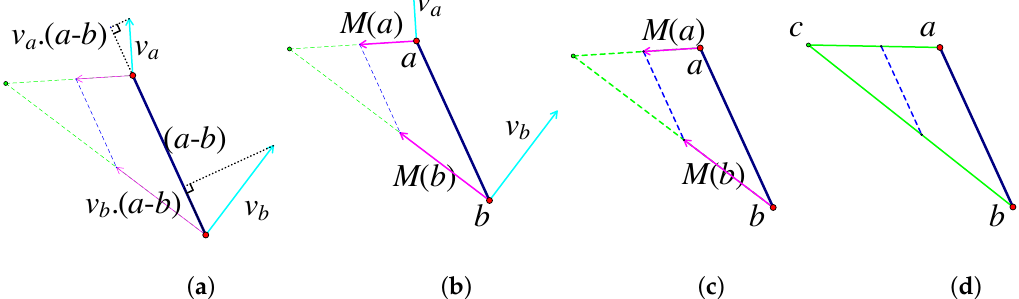
Figure 5. An infinitesimal motion has equal projections on a bar ( a ). In the plane, if the vectors are turned 90 degrees, we have weighted line segments or momenta for vertices in ( b ), whose lines meet in a point, and whose ends produce a segment parallel to the bar. This point is the center of motion ( c ) for the bar. A choice of scale for the weight of the center as a projective point generates a line parallel to the bar ( d